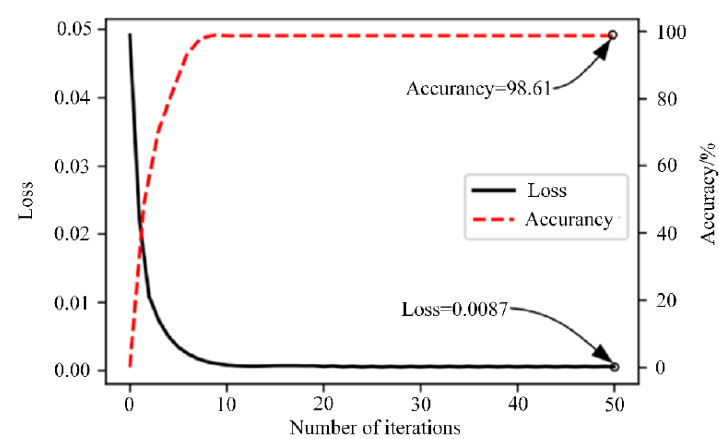
Figure 6. The change curve of ADBN 1 loss value and accuracy.